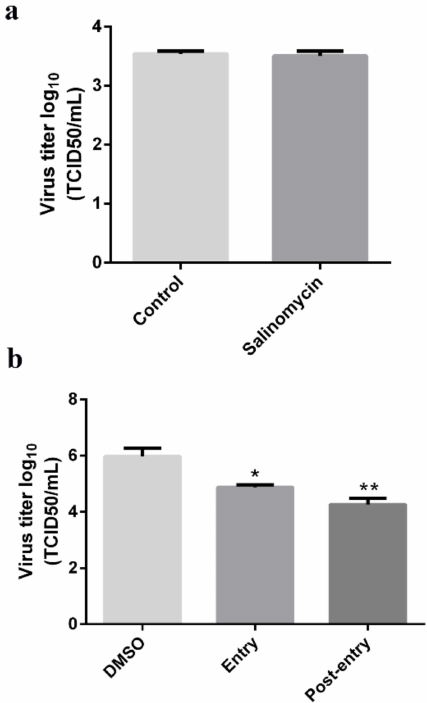
Figure 4. Antiviral effects of salinomycin on different stages of PEDV infectious cycle. Vero cells infected with PEDV were mock-treated with DMSO or treated with salinomycin at different stages of infection. ( a ) Viral titers (log10 TCID50/mL) from cells treated with salinomycin at the viral binding, ( b ) entry and replication stages as calculated by the method of Reed and Muench. The assays were performed in duplicate and data presented as means ± SD. * p < 0.05. ** p <